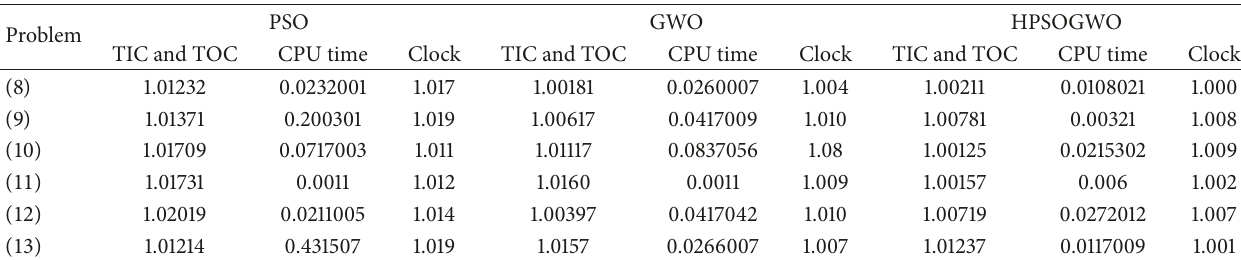
Table 11: Time-consuming results of multimodal benchmark